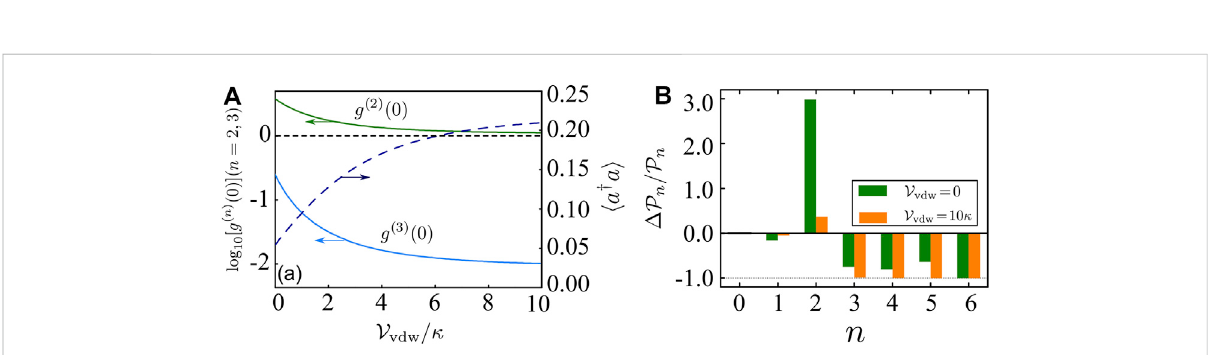
FIGURE 5 (Coloronline) (A) log 10 [ 〈 a † a 〉 ](blue-blackdashedcurve),log 10 [ g (2) (0)](greensolidcurve),andlog 10 [ g (3) (0)](wathetbluesolidcurve)fordifferent values of V vdw / κ in the case of Φ z = π with Ω C = 8 κ . (B) Relative deviations of photon number distribution with respect to the Poisson distribution. Other system parameters used here are the same as in Figure